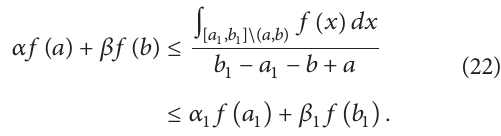
, then we take 𝑥 0 = 𝑦 0 = 𝑥 𝑖 and 0 0 , 𝑥 ) for some 𝑖 𝑖+1 𝑐 = 𝑝 𝑥 + 𝑞 𝑦 0 0 0 0 .